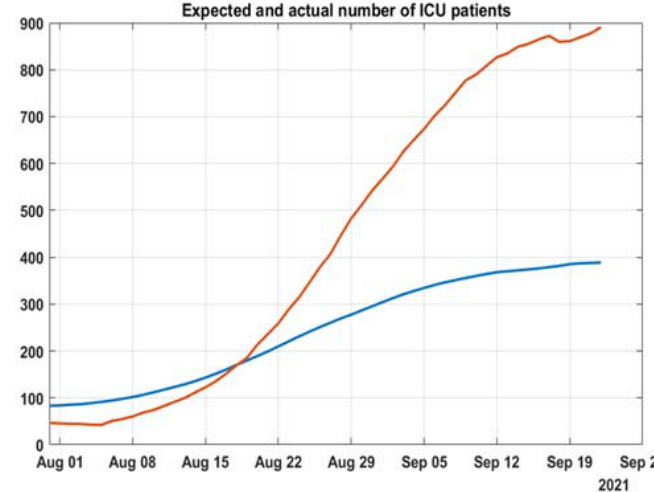
Figure 12. Discrepancy between model and actual ICU patients.